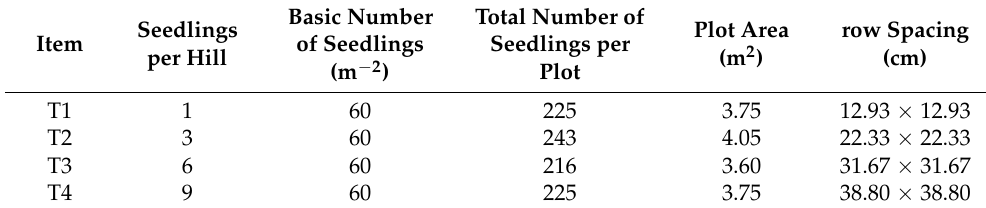
Table 10. Test plot area and plant-row spacing